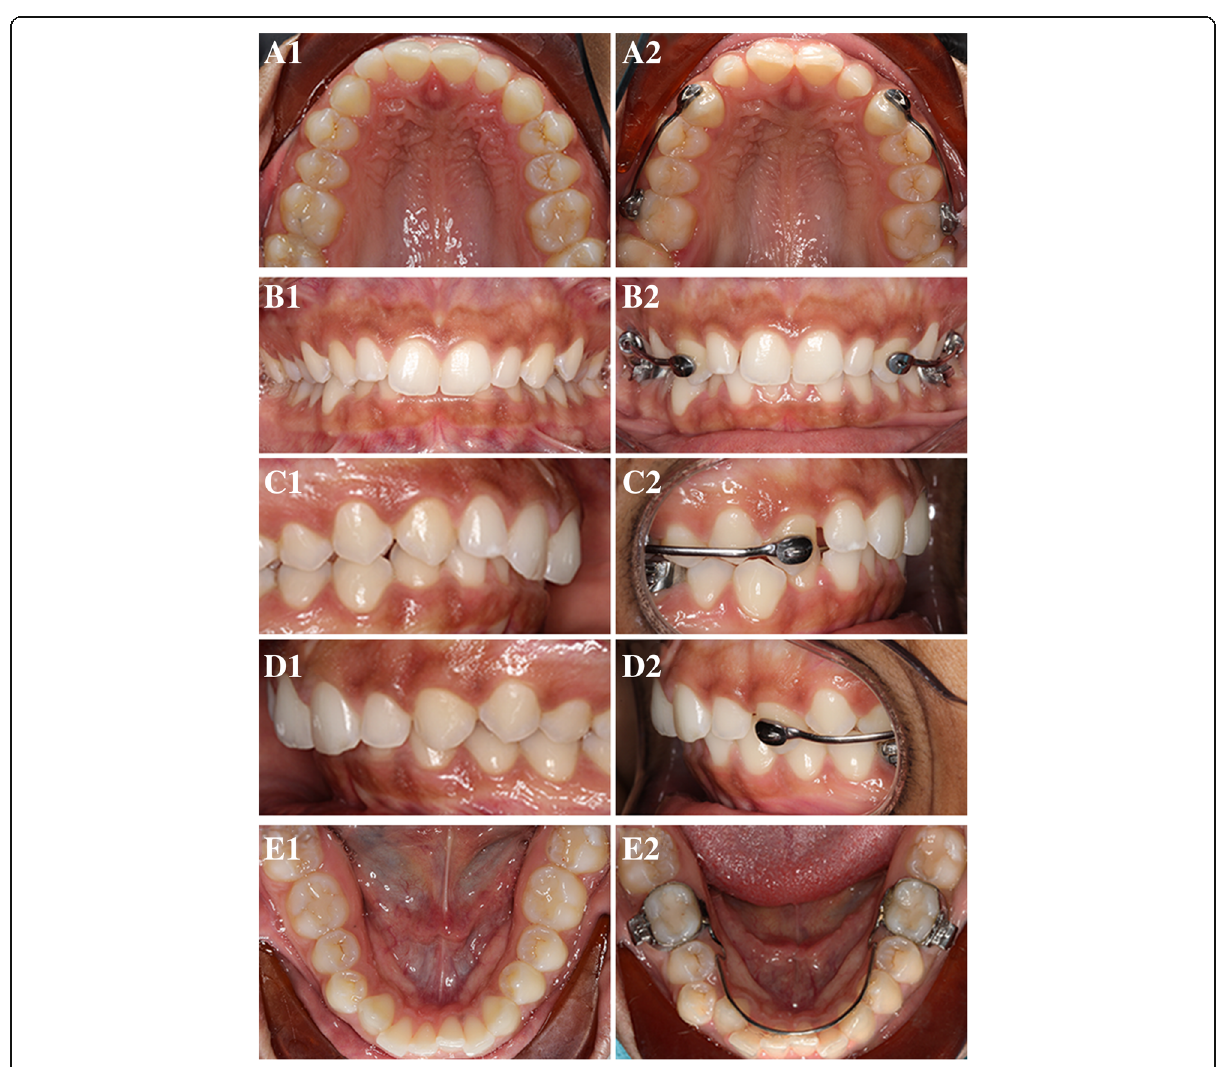
Fig. 8 Potential side effects induced by Carriere Distalizer . A1, B1, C1, D1, and E1 pre-treatment intraoral photos. A2, B2, C2, D2, and E2 intraoral photos taken after 4 months of treatment with Carriere Distalizer. The intermaxillary elastics supported by Carriere Distalizer and lower lingual holding arch or clear retainer may result in extra space distal to maxillary lateral incisors (A2, C2, and D2), extrusion of maxillary canines (B2, C2, and D2), and worsening in arch length discrepancy in the mandibular arch (E2-lower right buccal